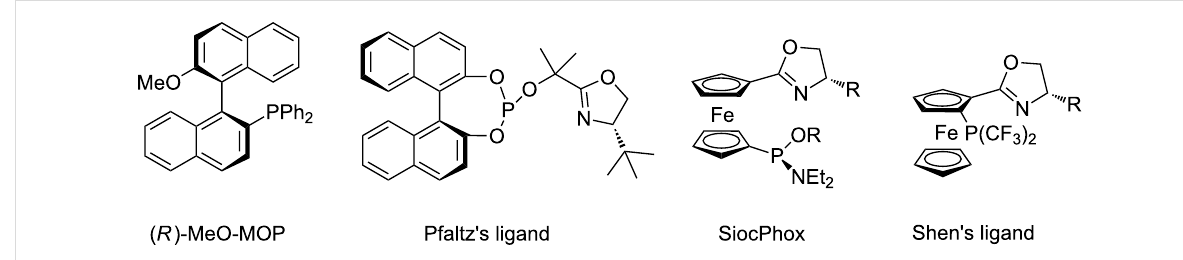
Figure 1: Representative ligands developed for the regio- and enantioselective Pd-catalyzed allylic alkylation.